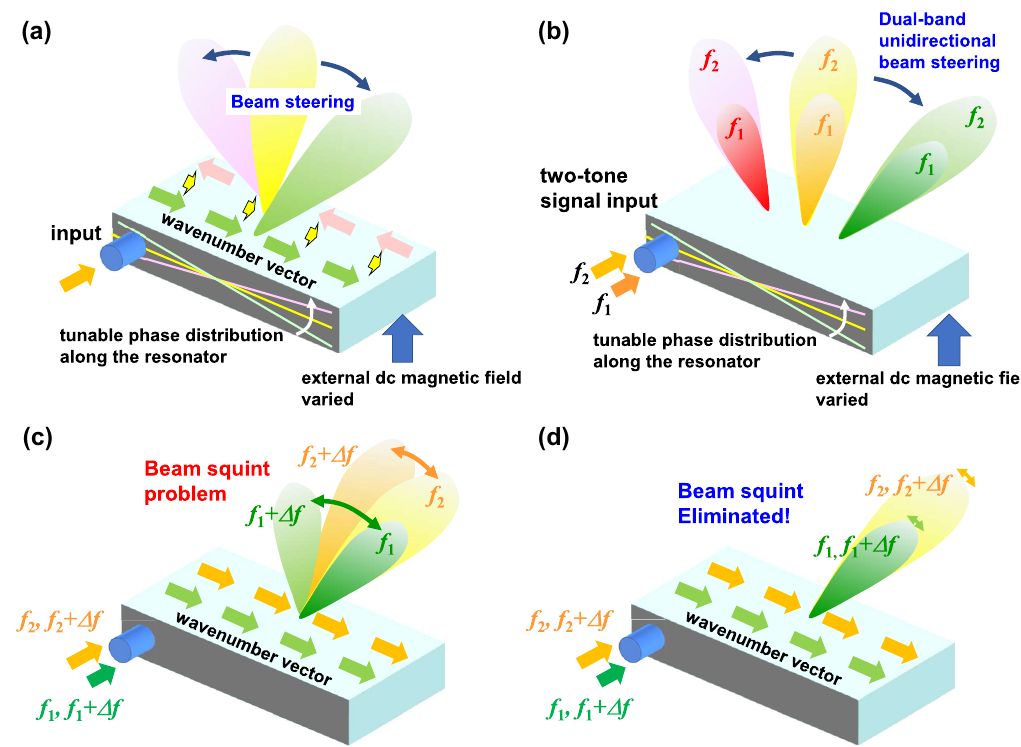
Figure 2: Schematic of beam scanning leaky wave antennas based on unidirectional traveling wave resonance using nonreciprocal CRLH metamaterial 1line.